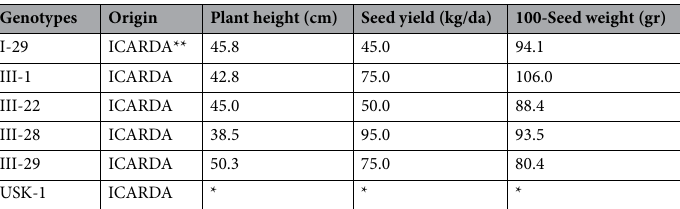
Table 9. Some morphological traits of genotypes. **International Center for Agricultural Research in the dry areas, *not